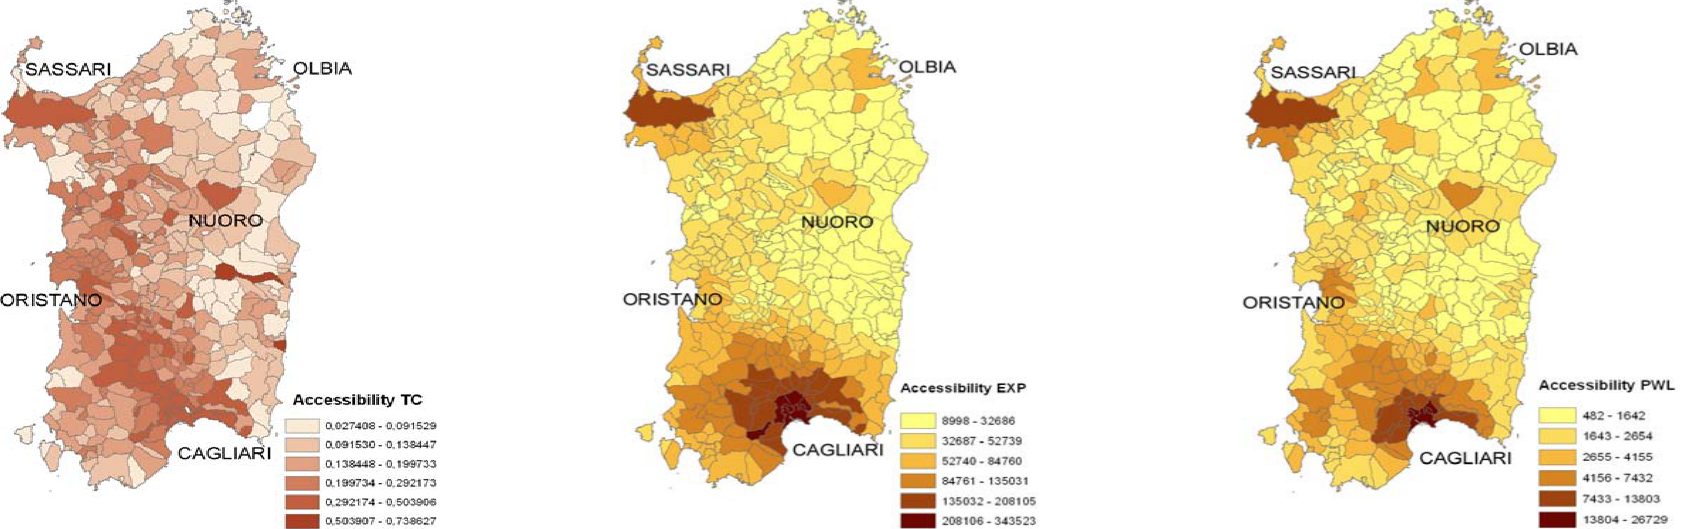
Figure 2. Maps of accessibility for commuters to municipalities of Sardinia, according to the travel cost approach (on the left), and to the spatial interaction model with impedance function in exponential (on the middle) and power (on the right) form.